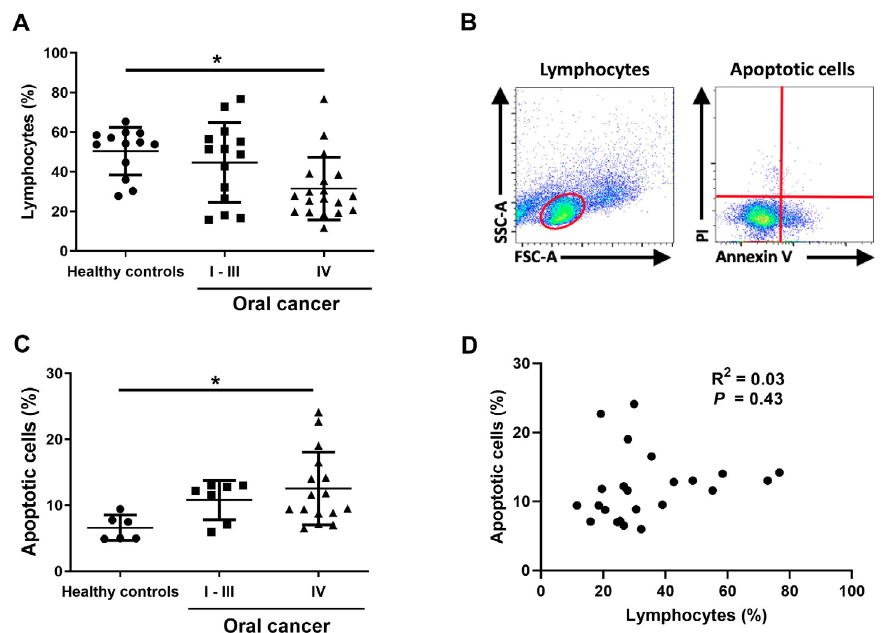
Figure 2- Percentage of lymphocytes. (A), Gated lymphocytes (B) and apoptotic cells (C). Correlations observed between the percentage of lymphocytes and apoptotic cells in OC cells (D) among the PBMCs obtained from the OC patients and HC. *: p